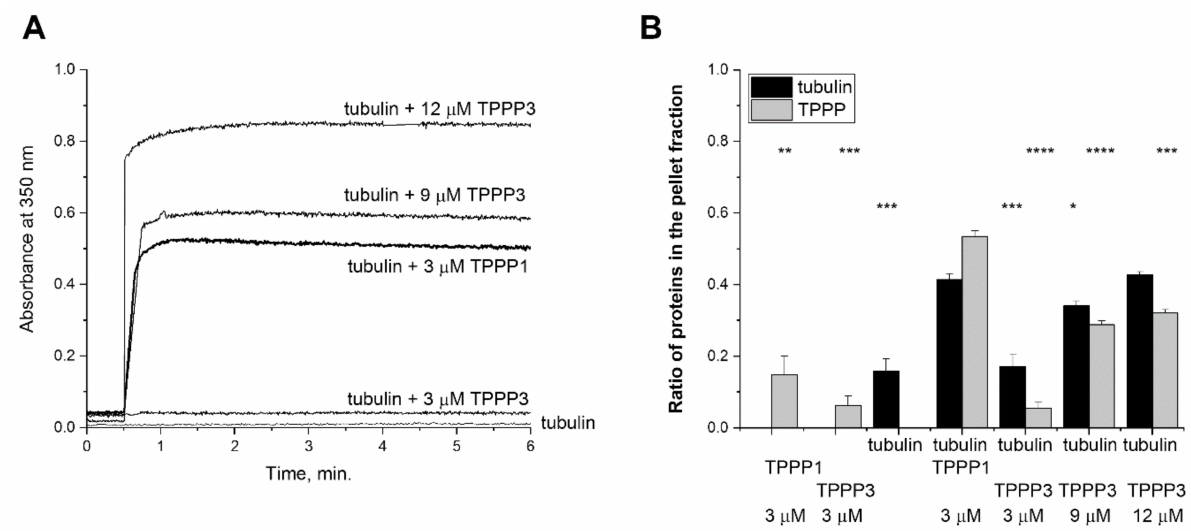
Figure 3. Interaction of TPPP3 and TPPP1 with tubulin. ( A ) TPPPs-induced tubulin polymerization was measured by turbidimetry; 3 µ M TPPP1 or 3, 9 or 12 µ M TPPP3 was added to 6 µ M tubulin. A representative experiment is shown. ( B ) The extent of the polymerization was quantified by pelleting experiments following the centrifugation of the samples (17,000 g, 10 min, 37 ◦ C); the pellet (P) and supernatant (S) fractions were loaded to 13.5% SDS-PAGE and the partition of the proteins in the pellet (P) fraction was quantified by densitometric analysis. Statistical comparisons were performed with two-sided, unpaired Student’s t -test, as compared to the control (tubulin + 3 µ M TPPP1) (* p < 0.05, ** p < 0.01, *** p < 0.001 and **** p <